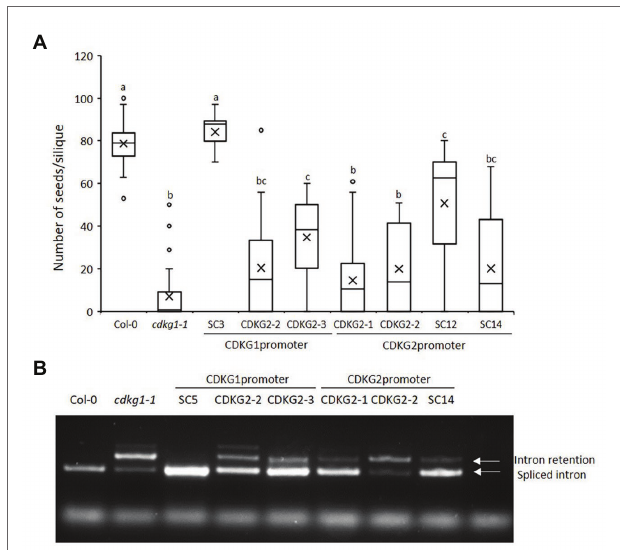
FIGURE 5 | CDKG2 is able to partially rescue the cdkg1-1 phenotype. (A) Fertility counts of the transformed plants. The average number of seeds per silique was determined for Col-0, cdkg1-1 , and lines expressing CDKG1 and CDKG2 under the control of the CDKG1 promoter or the CDKG2 promoter in a cdkg1-1 mutant background as indicated. Data represent average and the interquartile range for 30 siliques from three plants. Superscript letters represent significance groups for p < 0.001. (B) Splicing profile of the CalS5 mRNA in young inflorescences of the different lines as described above. In the wild type Col-0 only the spliced form is observed, while in the cdkg1-1 mutant both spliced and intron retention are observed. The extra high molecular weight band observed in some of the samples is possibly a result of RNA heteroduplex formation.